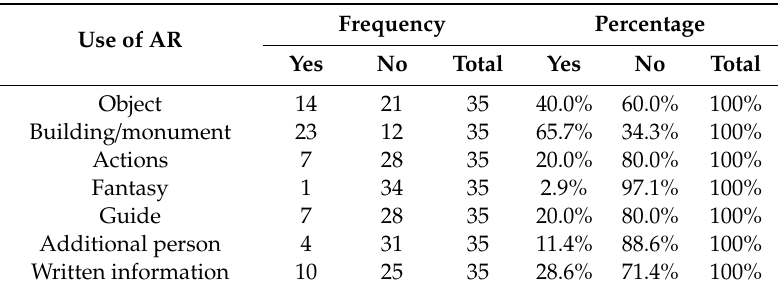
Table 4. Uses of AR in the app